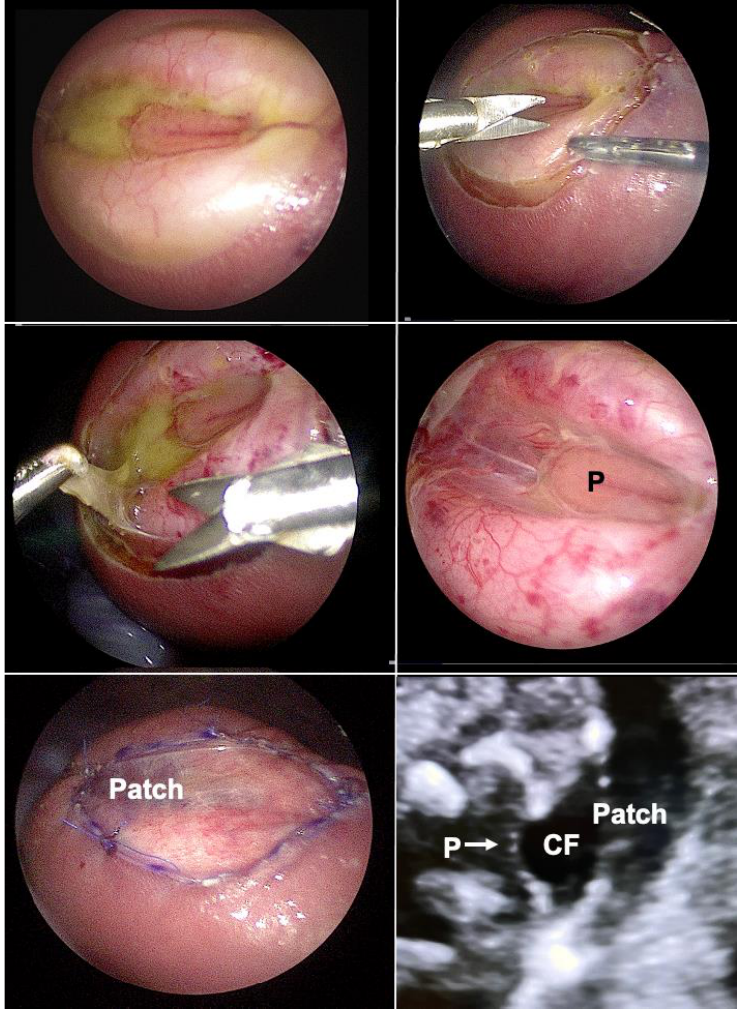
Figure 9. Top left — fetoscopic aspect of a flat myelomeningocele at the L4 level at 25 weeks of ges- tation after successful fetal posturing in the carbon dioxide-insufflated amniotic cavity. Top right — at first, the lesion is circumcised, then, the placode (P) and spinal nerves are carefully dissected from surrounding structures ( middle left and right ). The neural tissue is then covered water-tightly by a patch ( bottom left ). The patch has been trimmed in such a fashion that it permits sufficient accumu- lation of cerebrospinal fluid (CF) between the placode (P arrow) and the inner patch surface, greatly decreasing the risk for adhesions and avoiding compression ( bottom right ).